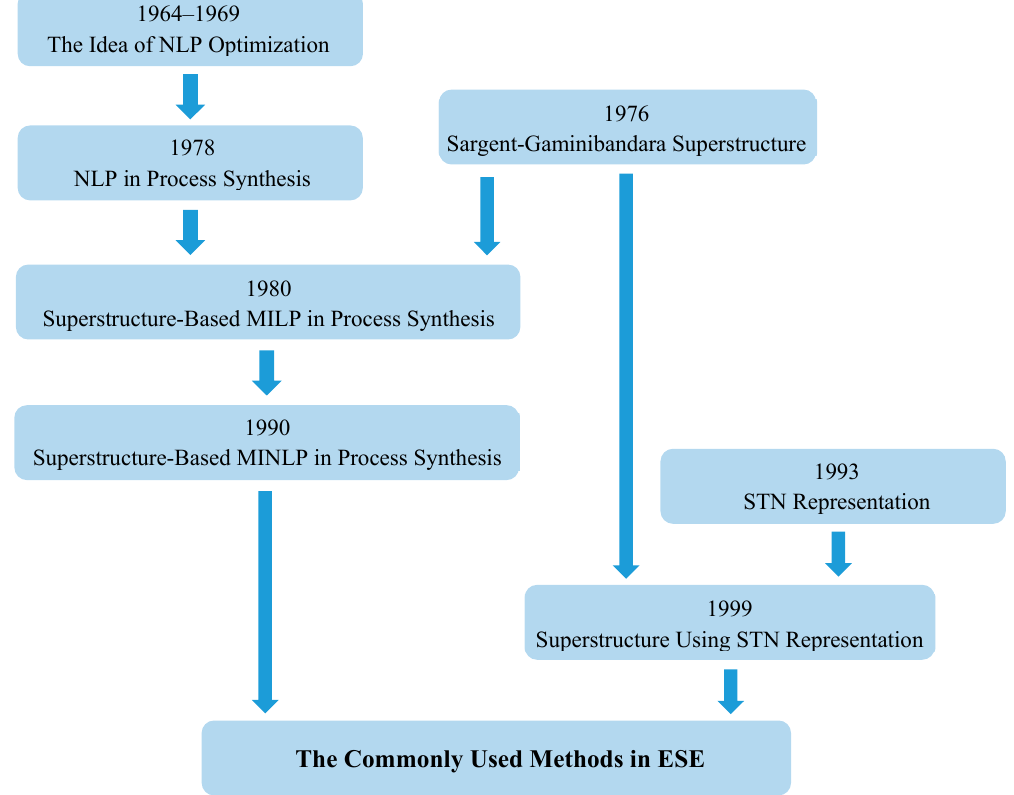
Figure 1. The development of Sargent’s work in optimum design to methods used in energy systems engineering (ESE).